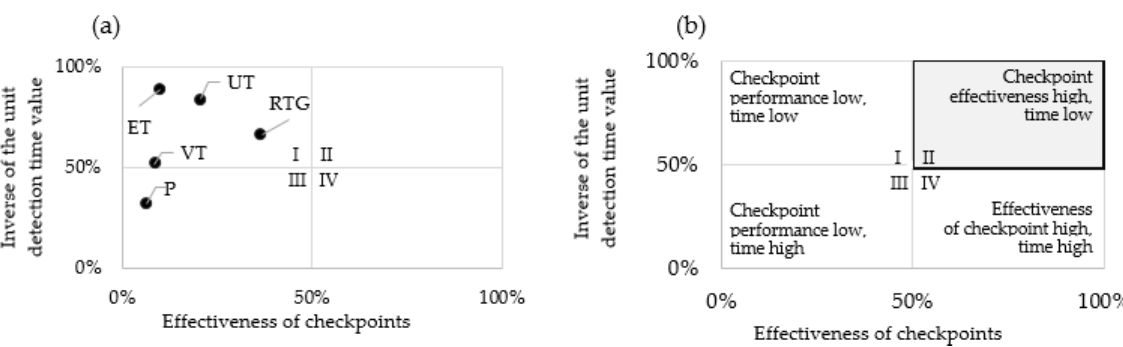
Figure 8. Matrix diagram showing ( a ) time efficiency of a given checkpoint, ( b ) overview diagram.